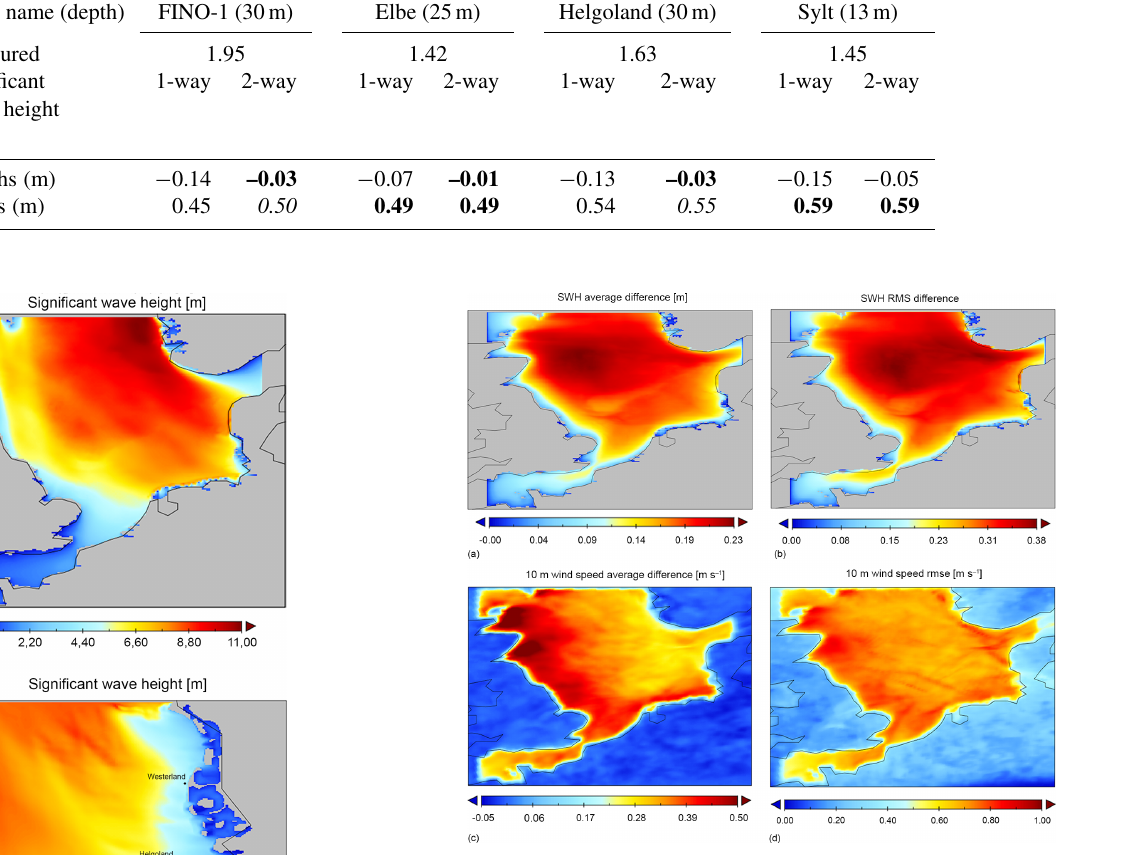
Figure 10. (a, c) Average difference and (b, d) rms difference (rms difference) of WAM modelled significant wave height (m, top pan- els) and COSMO modelled wind speed (ms − 1 , bottom panels) when comparing one-way minus two-way coupled modelling re- sults. The differences are calculated as averages over the whole 3- month